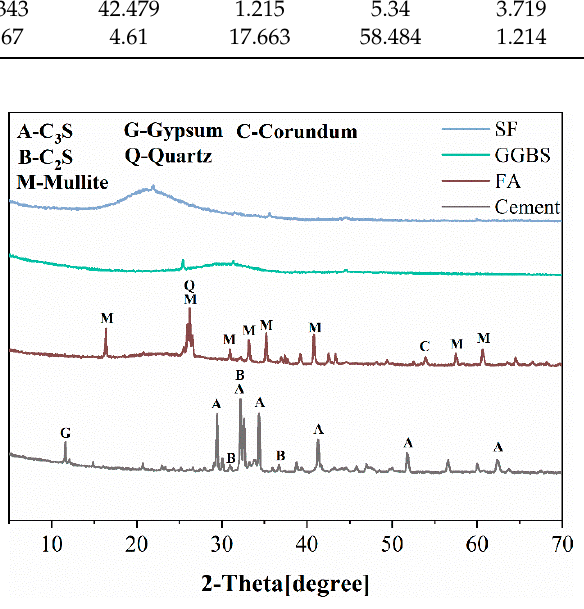
Figure 3. XRD patterns of materials.